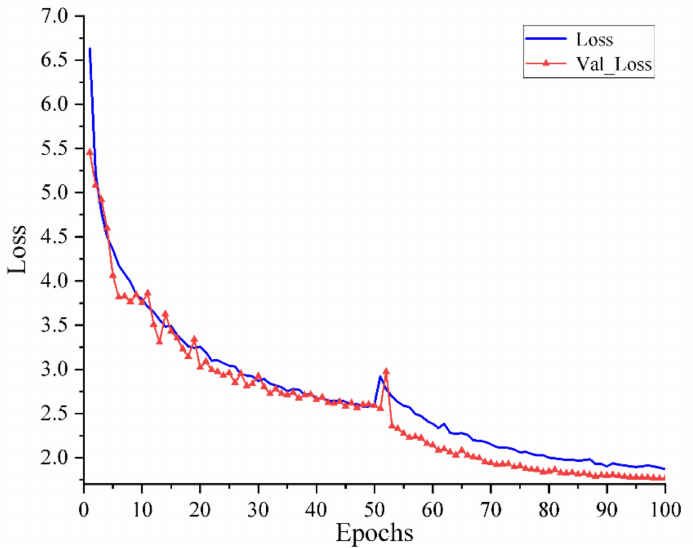
Figure 5. The training loss curve of the ECA-YOLOX-Tiny